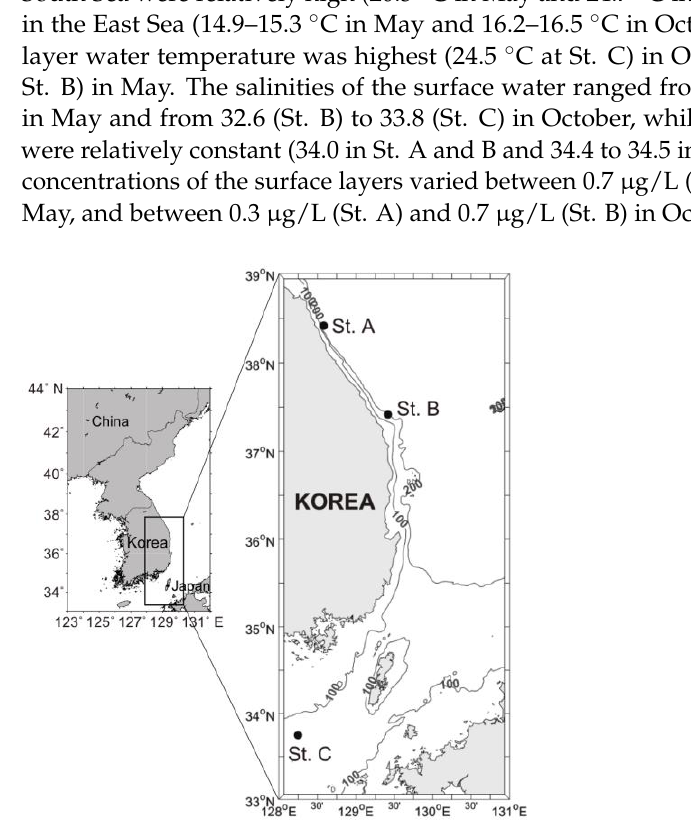
Figure 1. Map of the sampling area in the East Sea (St. A and St. B) and the South Sea (St. C). Field circles indicate the sampling site collected for suspended particulate organic matter (SPOM) and consumers (zooplankton and fish). Table 1. The surface and bottom environmental conditions (water temperature, salinity, and chloro- phyll a ) in the East Sea (St. A and St. B) and the South Sea (St. C) of Korea during May